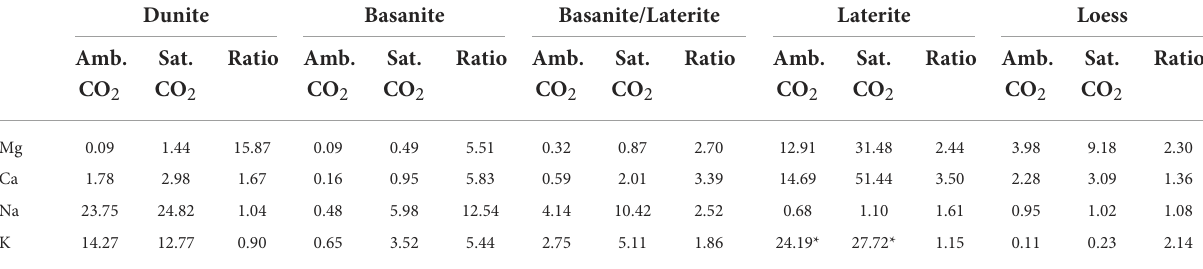
TABLE 4 Fraction of major cations (mole %) relative to the cation content of the fresh/unreacted column material released during the experiment phase. The resulting ratios between saturated and ambient CO 2 treatment can be interpreted as the maximum achievable ratios in the field since watering volumes were chosen to simulate tropical humid high precipitation rates with enhanced complete drainage. Dunite